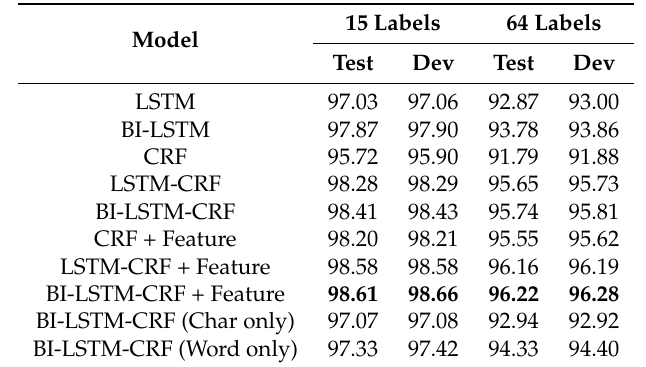
Table 6. Performance of the different models. “Word only” refers to the BI-LSTM-CRF model that uses word embeddings only, ”Char only” refers to the BI-LSTM-CRF model that uses character-level embeddings only, ”+ Feature” refers to the model that uses the engineered features which discussed in Section 4.2.1 (%).